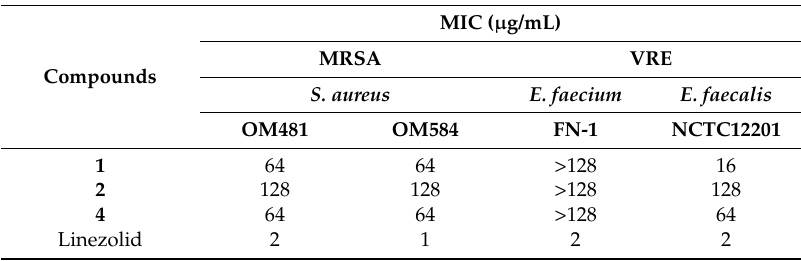
Table 1. Antibacterial effects of Davidia tannins.